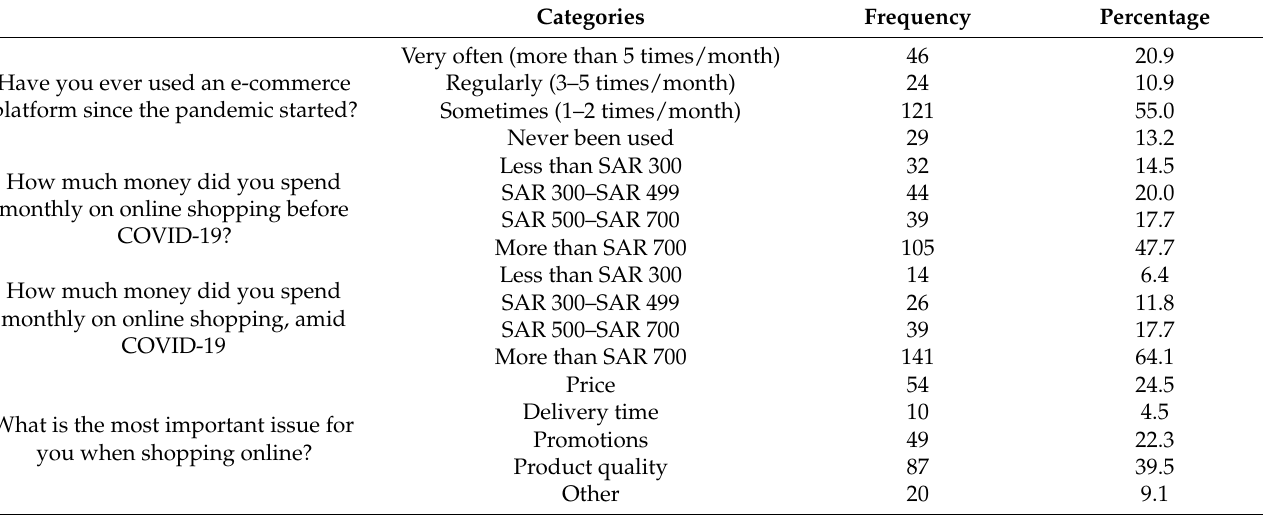
Table 2. Attitudes towards online shopping by the